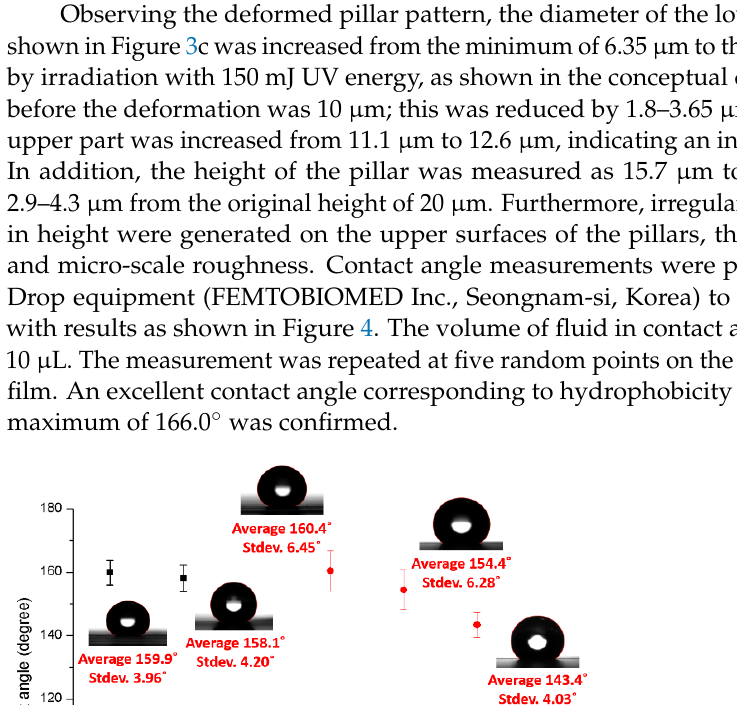
Figure 4. Contact angle measurement results of imprint film according to UV irradiation